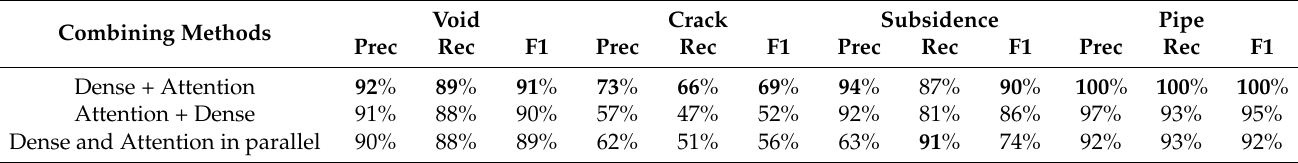
Table 5. Ablation experiments on combining methods of dense layer module and attention